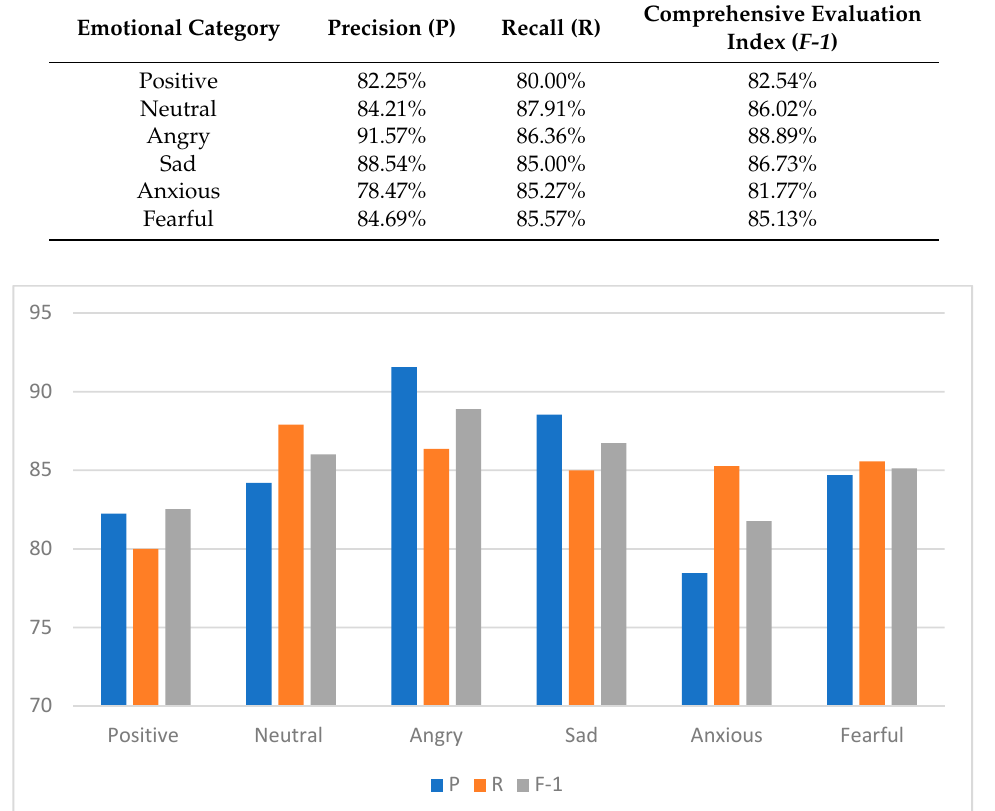
Figure 14. Classification accuracy of different emotions.